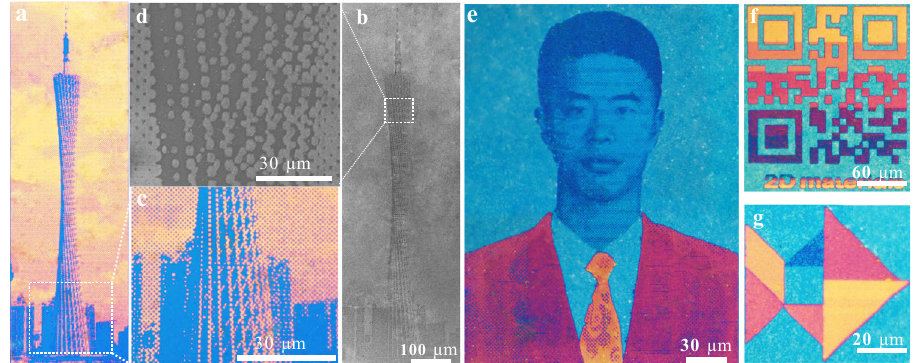
Fig. 3 High fi delity color images by laser exfoliated nanometric fl at prints. a , c Are optical microscopic image and zoom-in view. b , d Are SEM image and sectional zoom-in view. A collection of color images printed by the laser exfoliation method with atomic thickness precisions and subwavelength feature sizes in continuous tone ( f , g ) and half tone modes ( a , e ) demonstrates the capability of high color fi delity and high spatial Flat prints and binocular stereoscopic images . The ultra- image composed of subwavelength scale pixels can achieve a high spatial resolution up to 58,000 dpi. The minimum pixel size is sensitive resonance control allows the generation of nanometric fl at prints for color images 28 – 31 (Supplementary Fig. 8). measured around 400 nm given a focusing lens with a numerical Figure 3a – e are collections of halftone images patterned by laser aperture of 0.75. To demonstrate the up-scalability, a Canton writing methods. The color halftone effect is realized through Tower with a millimeter scale was printed with a high resolution controlling the printed pixel density. The underlying mechanism and high fi delity (Fig. 3a). Scanning electron microscope (SEM) of laser exfoliation can be attributed to photothermal effects, image of the prints is depicted in Fig. 3d. The SEM image and where the local heating effect and heat diffusion can be fl exibly optical micrograph of the selected region with fi ne details are controlled by the focusing conditions to pattern subwavelength shown in Fig. 3b, c, respectively. Figure 3f – g show another feature sizes. By dexterous control the laser recipe, the patterned example of images or even color QR codes printed with